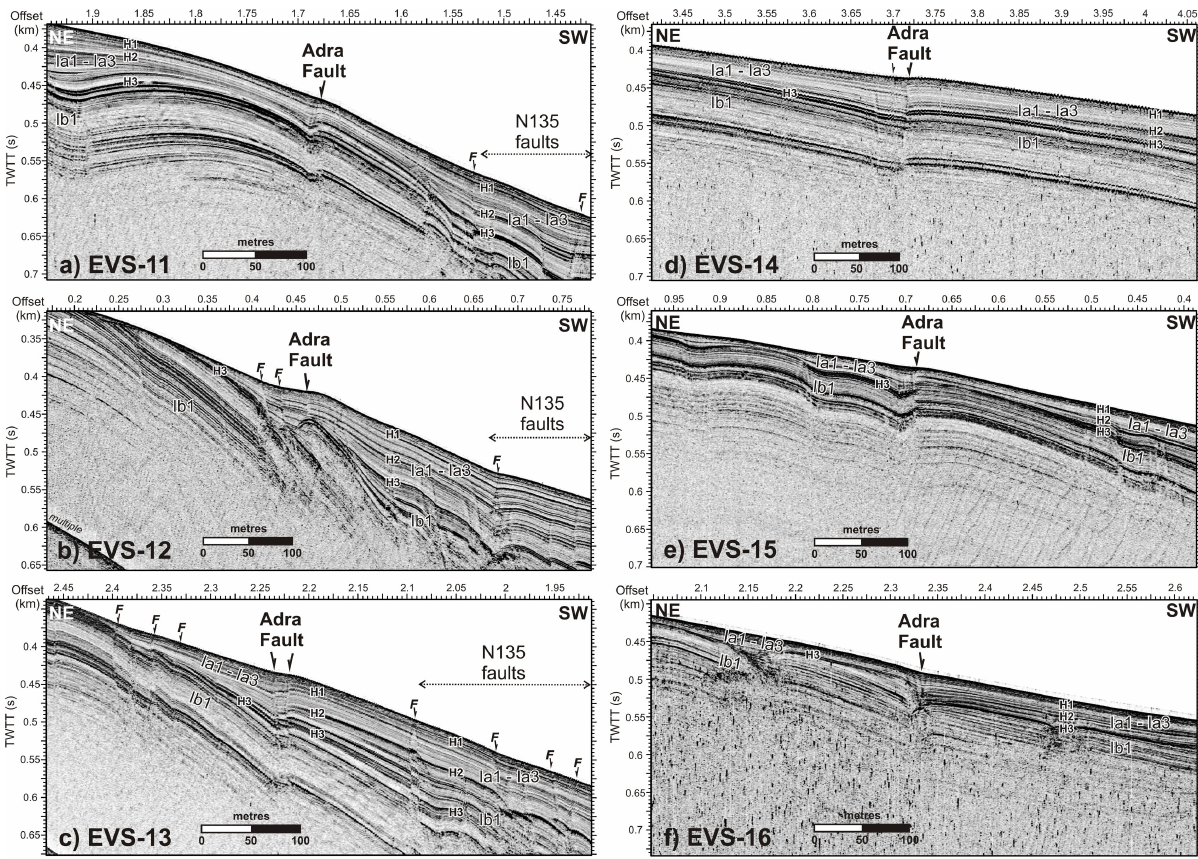
Fig. 6. Succession of Sparker profiles EVS-11 to EVS-16 across the Adra Fault. Age of horizons are H1: Late Quaternary, H2: Early Quaternary (1.8Ma), and H3: Late Pliocene (3.6Ma). Vertical exaggeration at the seafloor ∼